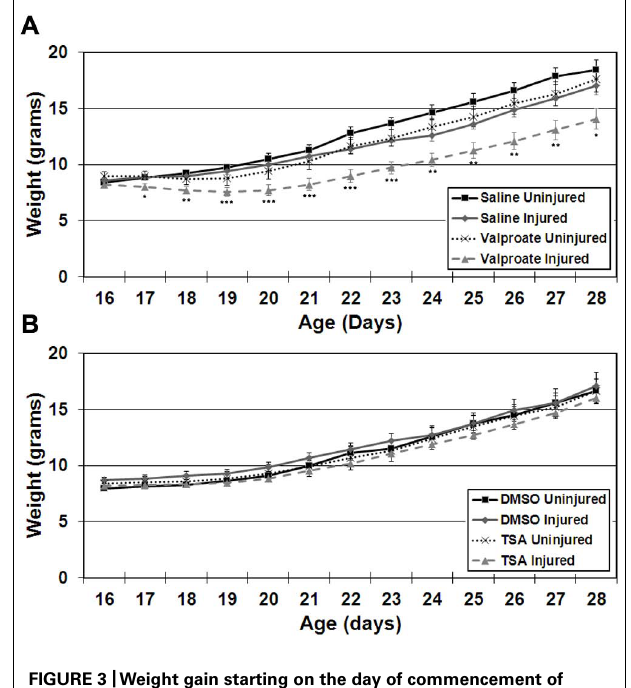
FIGURE 3 |Weight gain starting on the day of commencement of treatment (P16) until cessation of treatment (P28) in ligation-uninjured and ligation-injured mice (A) treated with valproate or saline-vehicle (Protocol 2) or (B)TSA or DMSO-vehicle (Protocol 2; * p < 0.05, ** p < 0.01, *** p <